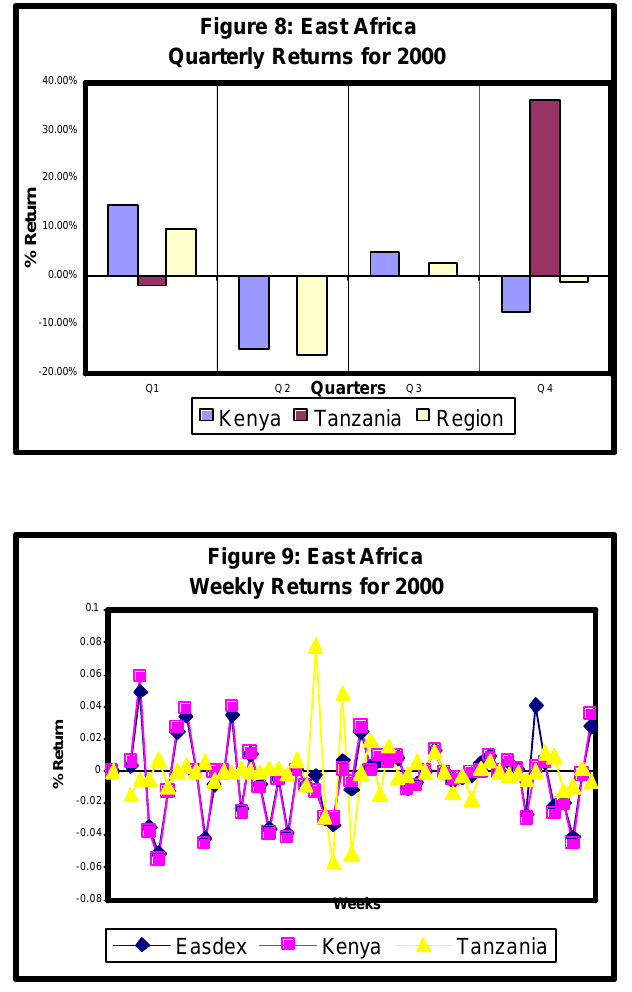
Figure 8: East Africa